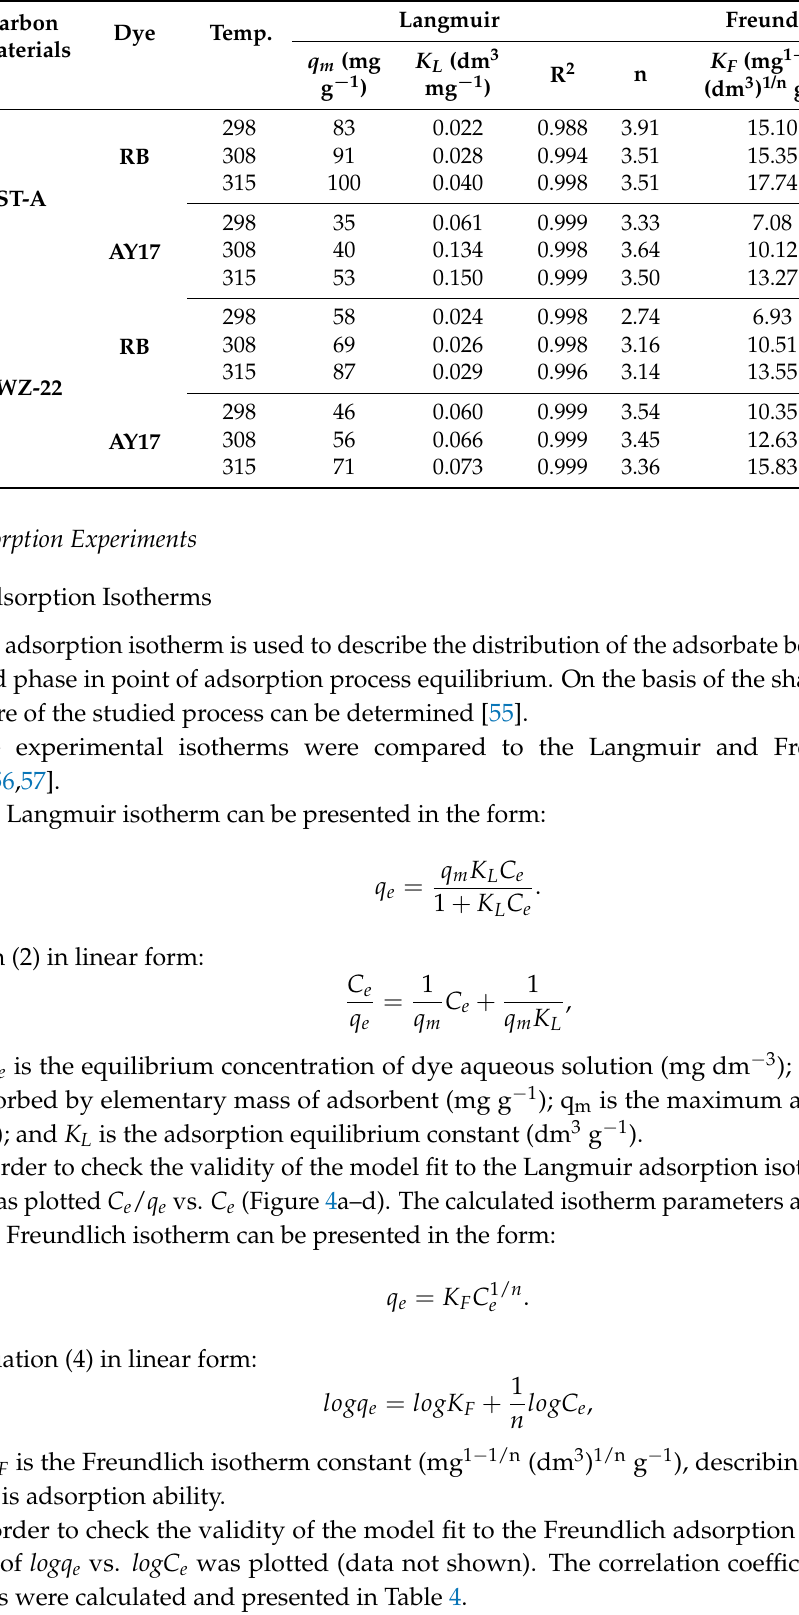
Table 4. Langmuir and Freundlich isotherm parameters for the RB and AY17 adsorption on studied